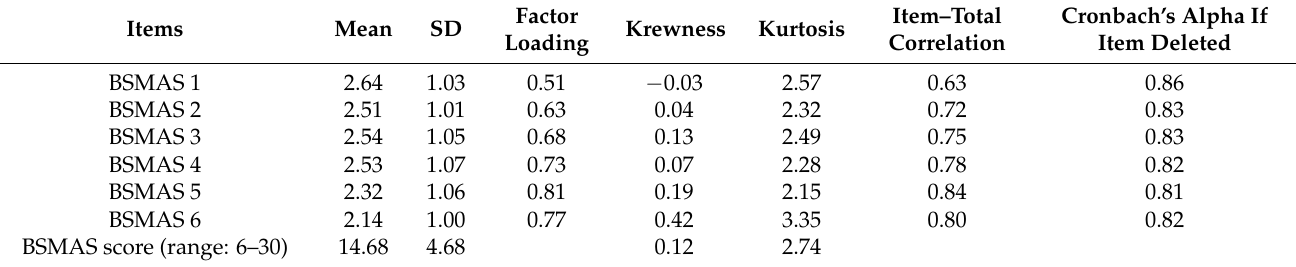
Table 3. Basic descriptions and reliability of Bergen Social Media Addiction Scale (BSMAS).